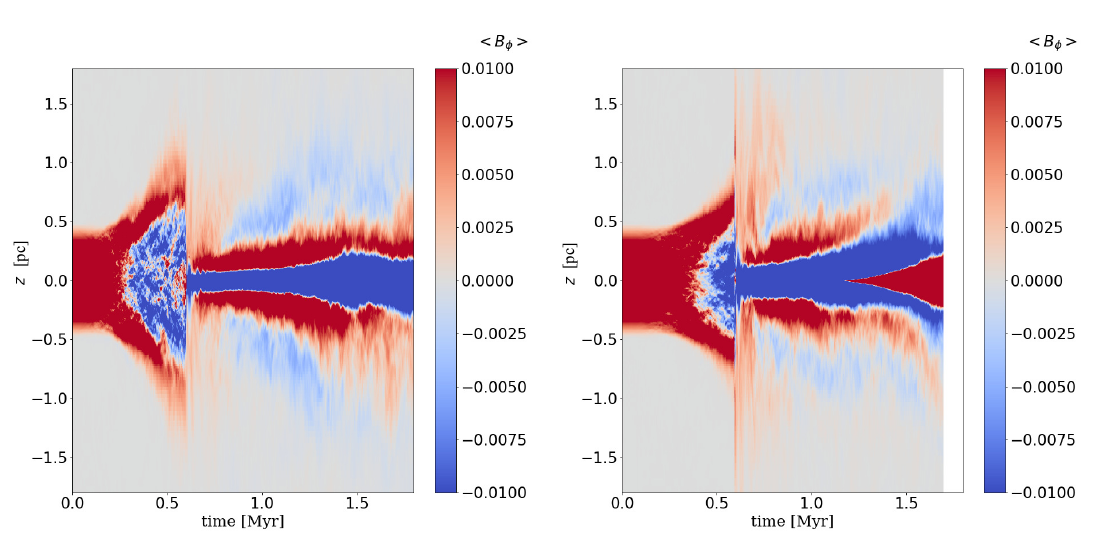
Figure 4. Butterfly diagram: time evolution of B ϕ averaged by azimuthal direction at r = 1 [pc]. Color contour of red and blue denotes the different sign of B ϕ . The left and right panels denote the low resolution N ϕ = 128 and high resolution N ϕ = 512, respectively. Time evolutions from the adiabatic phase to the cooling/heating phase are switched with t ∼ 0.60